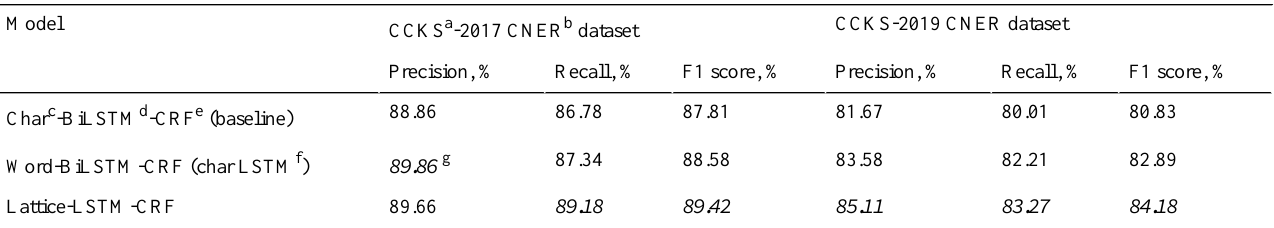
Table 6. Comparison of results between character-based or word-based methods and the lattice long short-term memory (LSTM) model on two